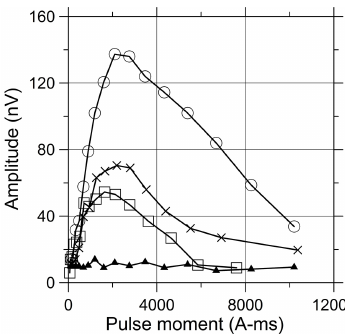
Fig. 7. 3-D-SNMR water volume estimated before each pumping against the water volume extracted by